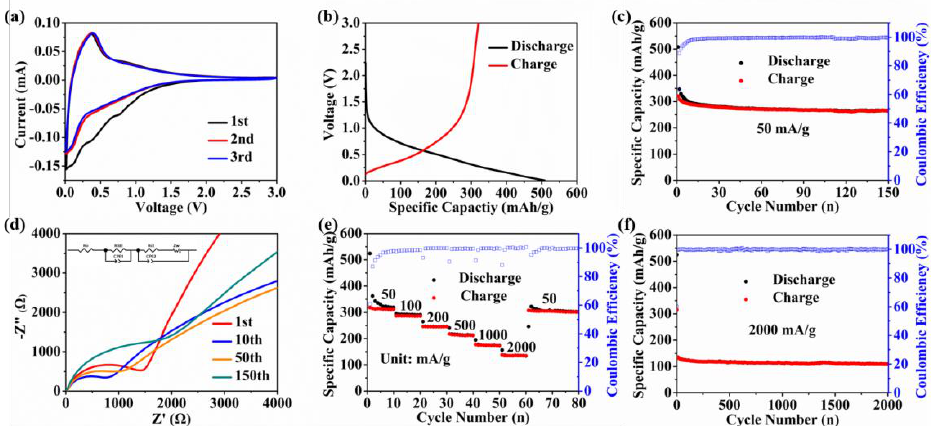
Figure 2. ( a ) CV curves scanned at a rate of 0.1 mV/s. ( b ) Galvanostatic charge/discharge curve at a current density of 50 mA/g. ( c ) Cycling performance. ( d ) Rate capability. ( e ) Long − term cycling stability. ( f ) Nyquist plots and equivalent circuit.